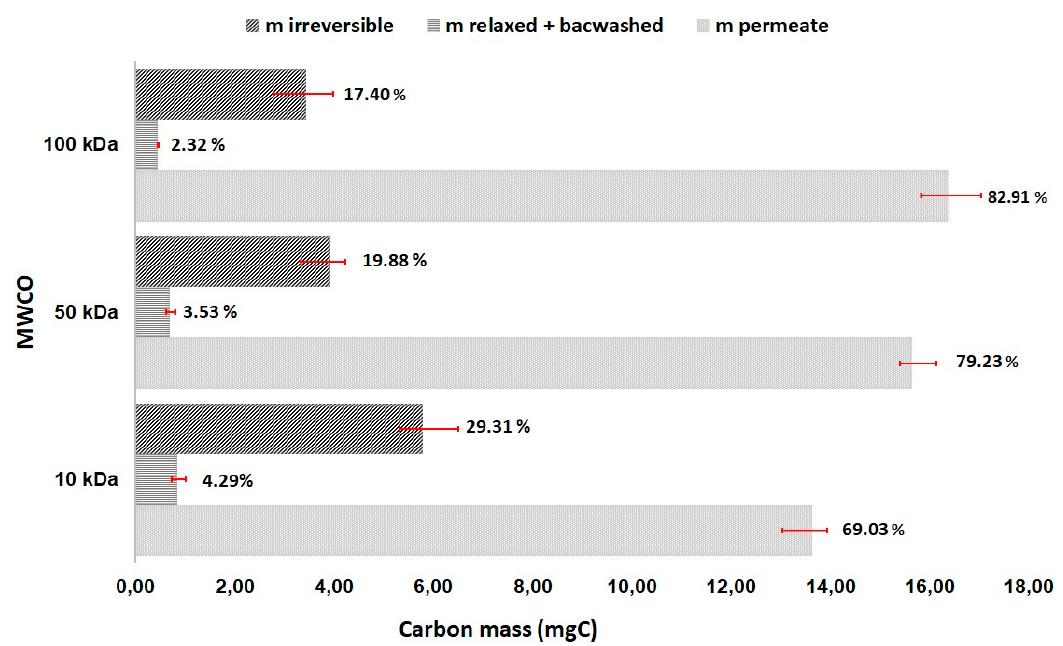
Figure 5. Carbon mass balances during UF for different MWCO, m feed = 19.76 ± 0.5 mg C.